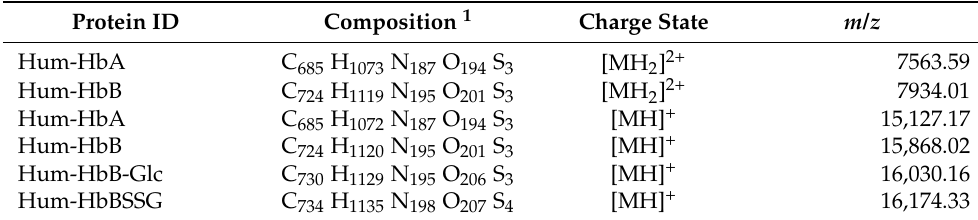
Table 1. Calculated elemental composition and m/z value of the main protein species of interest in the MALDI spectra of human red blood cell